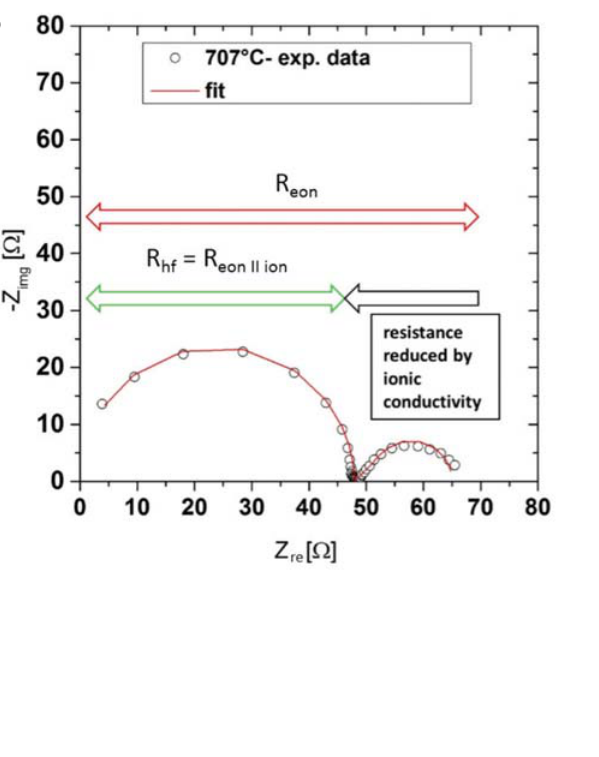
at 676 °C for 30 minutes, measured by 2